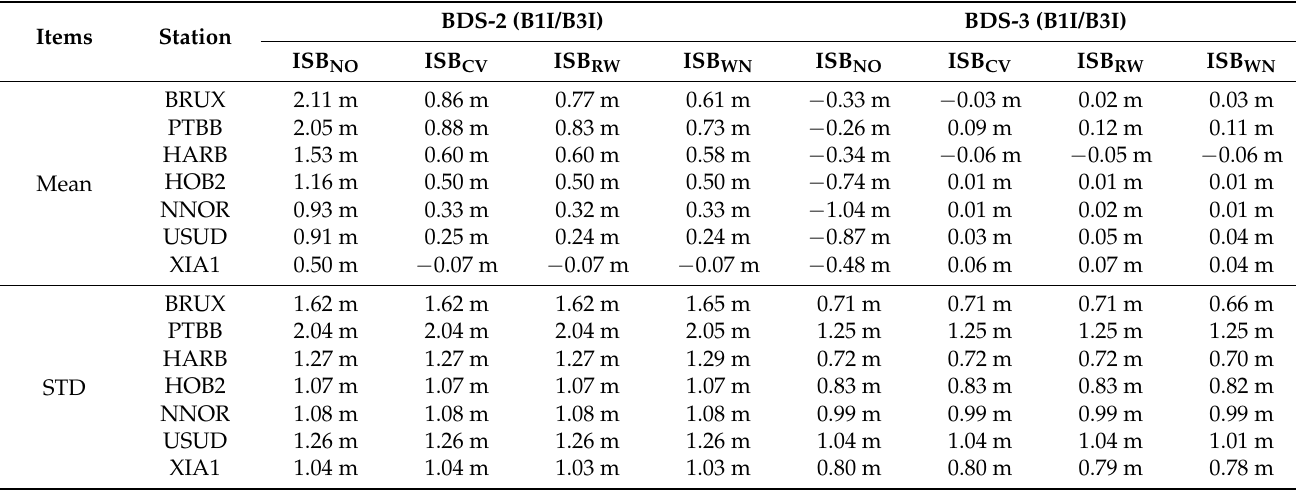
Table 5. The mean and STDs of observation residuals of BDS-2 (B1I/B3I) and BDS-3 (B1I/B3I) satellites for four ISB stochastic models based on GFZ products.